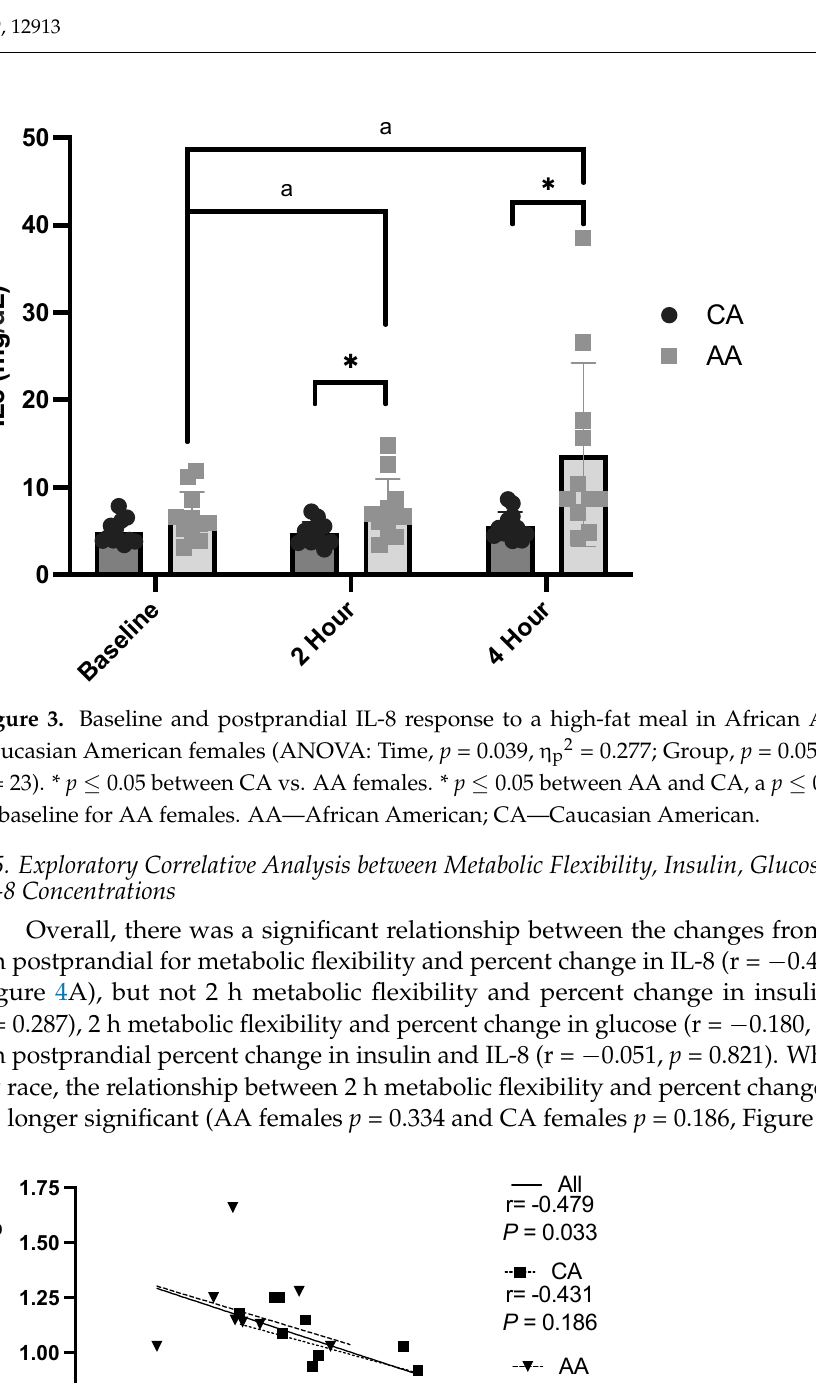
Figure 4. Exploratory correlative analysis between IL-8 percent change and metabolic flexibility from baseline to 2 h postprandial in response to a high-fat meal. AA—African American; CA—Cau- casian American.